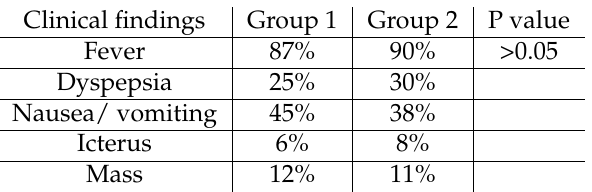
Table 2. Comparison of clinical features in